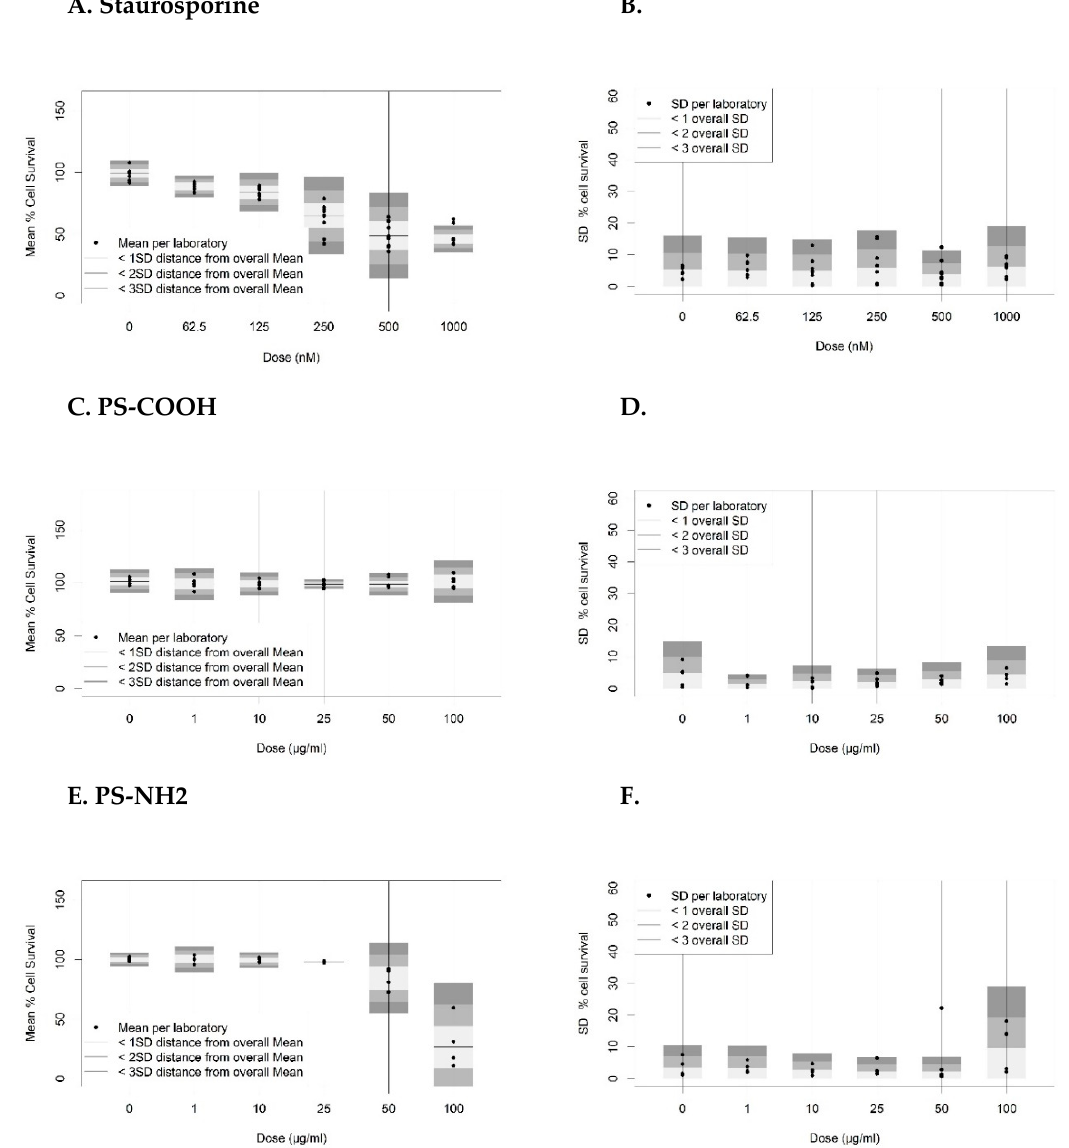
Figure 2. Intra- and inter-laboratory biases for percentage cell survival determined using the MTS assay based on valid runs (tier 2). Mean percentage cell survival per dose and per laboratory compared to the overall mean and SD (left panels), as well as SD of percentage cell survival per dose and per laboratory compared to the overall SD* (right panels) are shown for ( A , B ) staurosporine (N = 8), ( C , D ) carboxyl-modified polystyrene nanoparticles (PS-COOH) (N = 5) and ( E , F ) amine-modified polystyrene nanoparticles (PS-NH2) (N = 4). Horizontal bars (left panel) indicate overall mean values of percentage cell survival, while grey shaded areas indicate the distances from the overall mean corresponding to 1-, 2- or 3-fold the overall SD (left panels) or SD* (right panels).